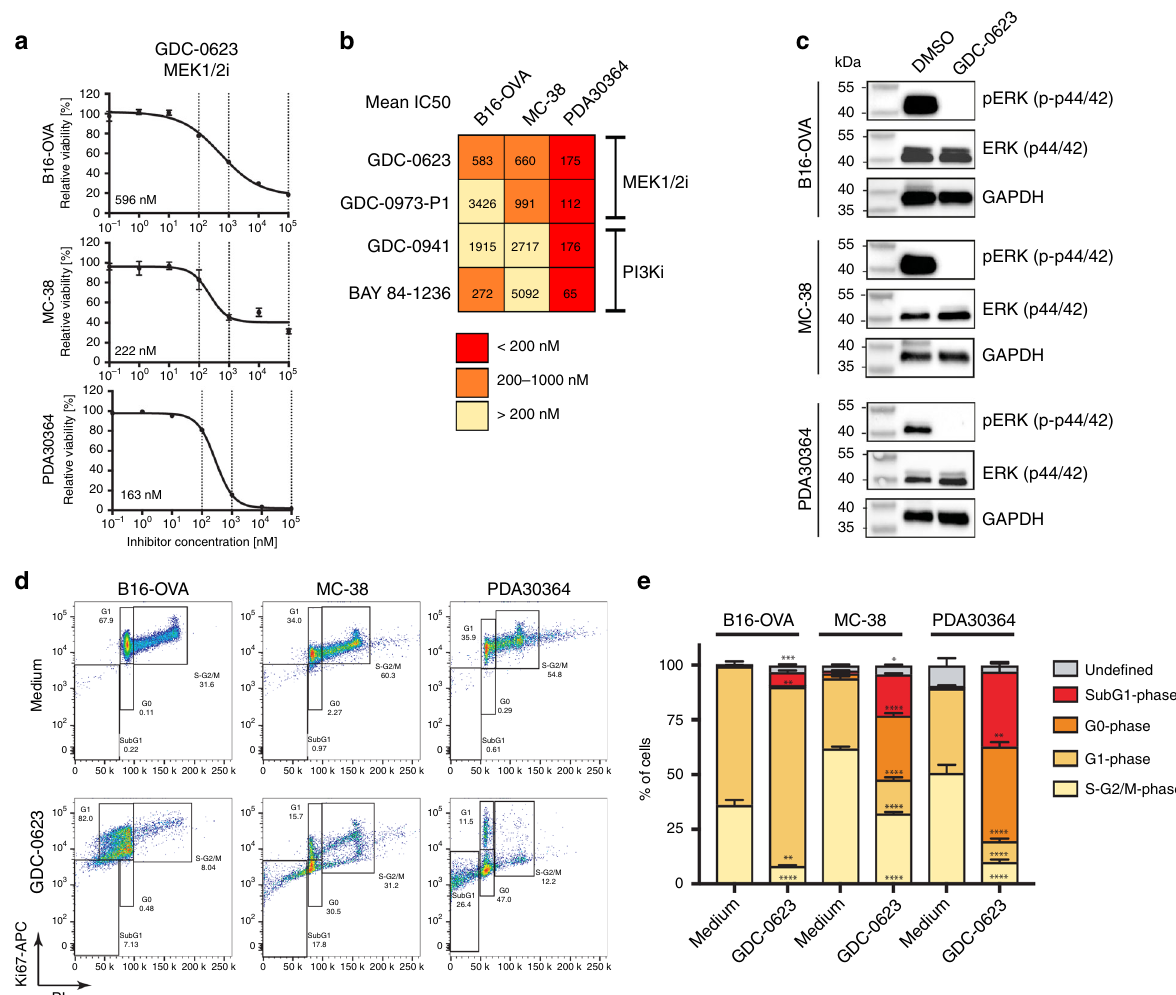
Fig. 1 In vitro potency of MEK and PI3K inhibitors against syngeneic tumor cell lines. ATP-based assessment of tumor cell viability in presence of indicated concentrations of small molecule inhibitors. Relative cell viability normalized to medium control. Inhibitory concentration (IC) 50 values calculated with 4-parameter logistic curve fi t with bottom constraint >0. Mean ± s.e.m, n = 3. a Representative dose – response curves of murine tumor cell lines. b Mean IC50 values for indicated murine tumor cell lines of three independent experiments. Each experiment comprises three biological replicates. Shading indicates level of inhibitor potency (red: < 200 nM = sensitive; orange: 200 – 1000 nM = moderate; light yellow: > 1000 nM = not sensitive). c Western Blot analyses of indicated murine tumor cell lines treated with 0.5 µ M GDC-0623 for 1 h. Representative data shown from two technical replicates. d , e Ki67/PI-based cell cycle analyses of tumor cells treated with 1 µ M GDC-0623 and respective quanti fi cation. Mean ± s.e.m, n = 3. Unpaired student t test (medium vs. GDC-0623 for each cell cycle phase; FDR ( Q = 1%), two-stage step-up method of Benjamini, Krieger and Yuketieli). Signi fi cance levels are indicated by asterisks (* p ≤ 0.05; ** p ≤ 0.01; *** p ≤ 0.001; **** p ≤